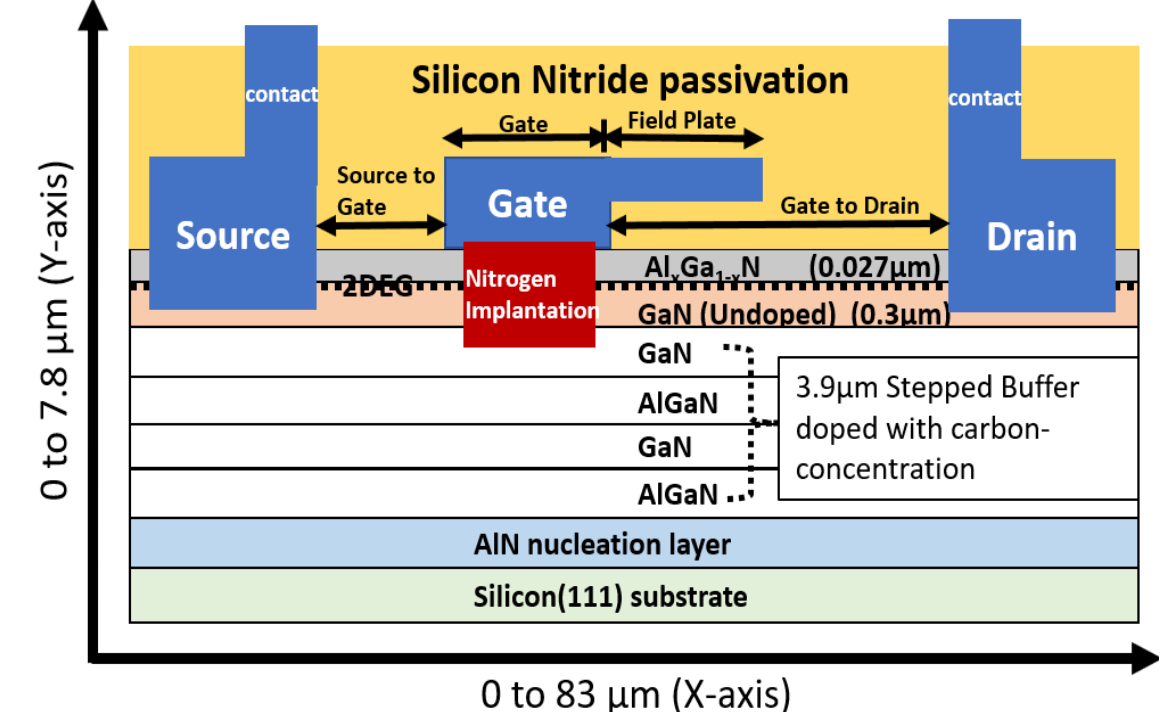
Figure 1. Schematic AlGaN/GaN HEMT device structure.